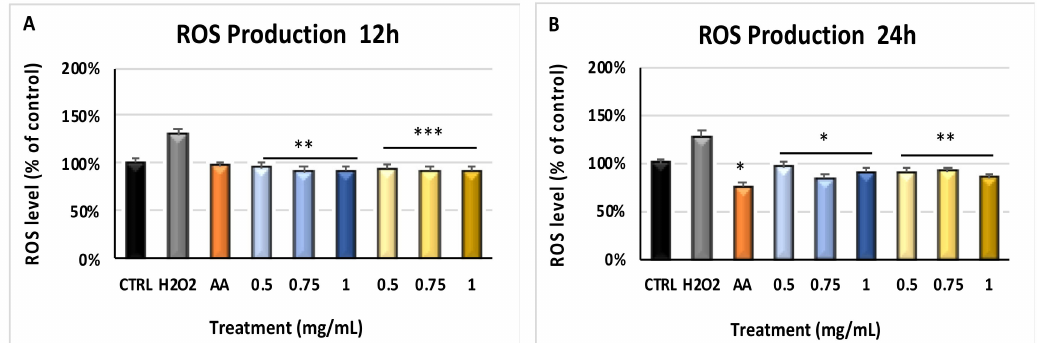
Figure 1. ROS levels after oxidative stress. The reactive oxygen species (ROS) production was evaluated in HFF1 exposed for 12 h (Panel ( A )) or 24 h (Panel ( B )) to ascorbic acid (AA, orange bar) or to 0.5, 0.75 and 1 mg / mL seeds (blue bars), or to 0.5, 0.75 and 1 mg / mL pulp (yellow bars) waste extracts, then induced to oxidative stress. “H 2 O 2 ” (grey bar) represents HFF1 cells exposed to H 2 O 2 alone,